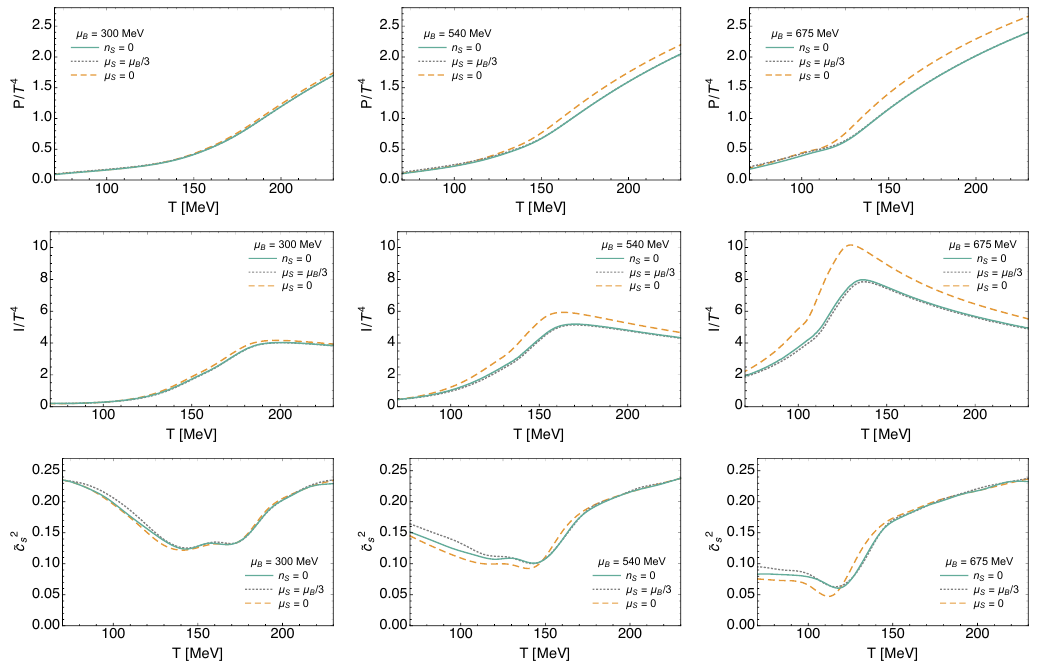
Figure 6: Comparison between the pressure (first row), the trace anomaly (second row) and the speed of sound squared (third row) at strangeness neutrality (solid blue = 0 (dashed orange line) and at µ line), at µ S µ ; see Eq. (54) for the definitions of these B